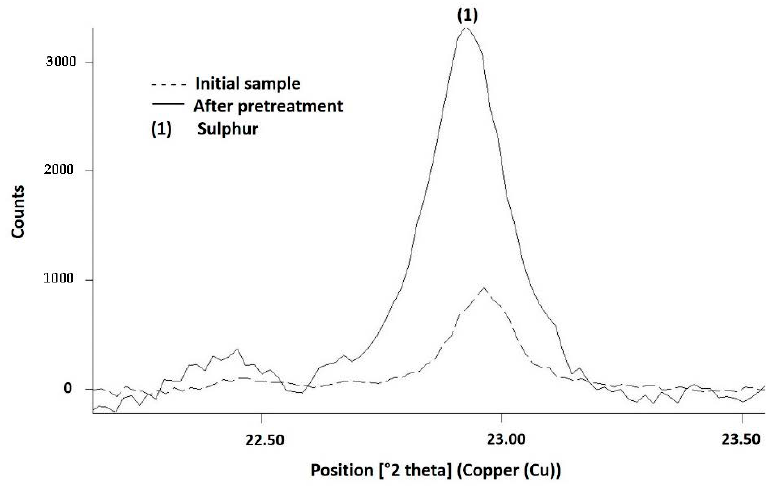
Figure 9. Elemental sulphur identification by X-ray diffraction analysis in copper sulphide ore pretreated with 15 kg/t of H 2 SO 4 , 25 kg/t of NaCl, and 15 days of curing at room temperature. SEM analysis was used to identify species formed during the pretreatment. As in